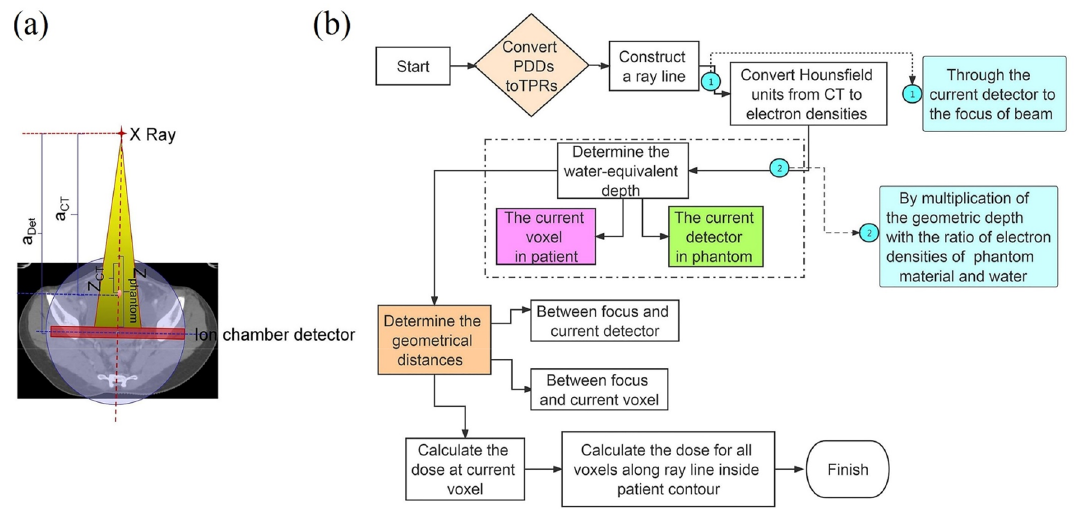
Figure 2. Reconstructing 3D dose on CT dataset. (a) Schematic illustration of dose reconstructed on an abdominal CT image. Dose measured by the current detector at the water-equivalent depth Z Phantom corresponds to the dose of the current voxel at the water-equivalent depth Z CT in CT image. a Det and a CT are geometrical distances from the focus of X-ray to the current detector and voxel, respectively. (b) Flow chart of the reconstruction